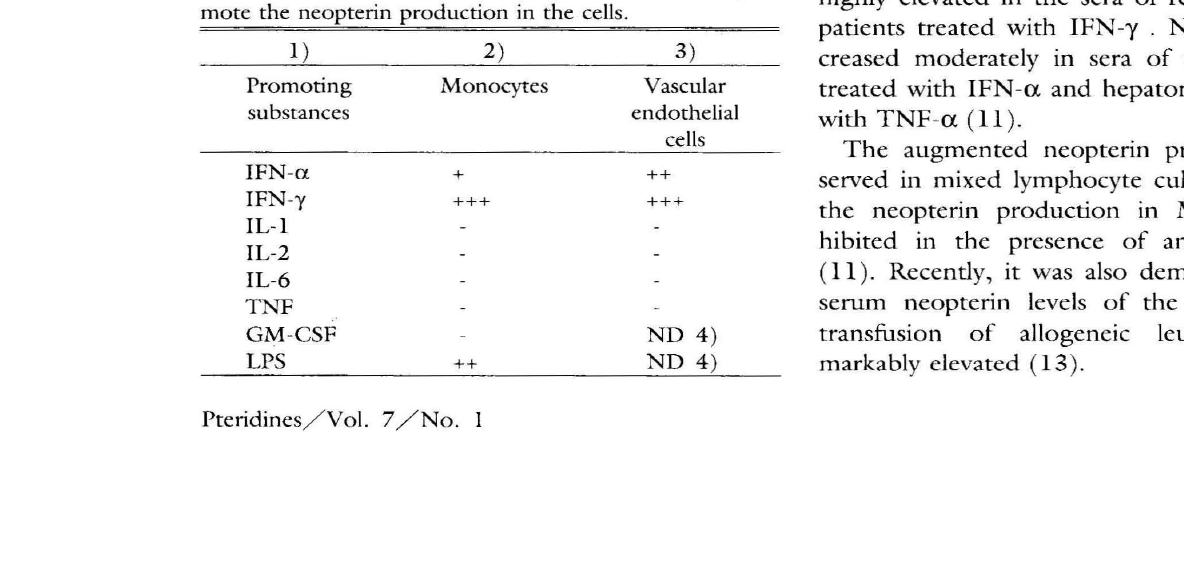
Table 1. Neopterin production by monocytes and vas cular endothelial cells in vitro and substances that pro mote the neopterin production in the